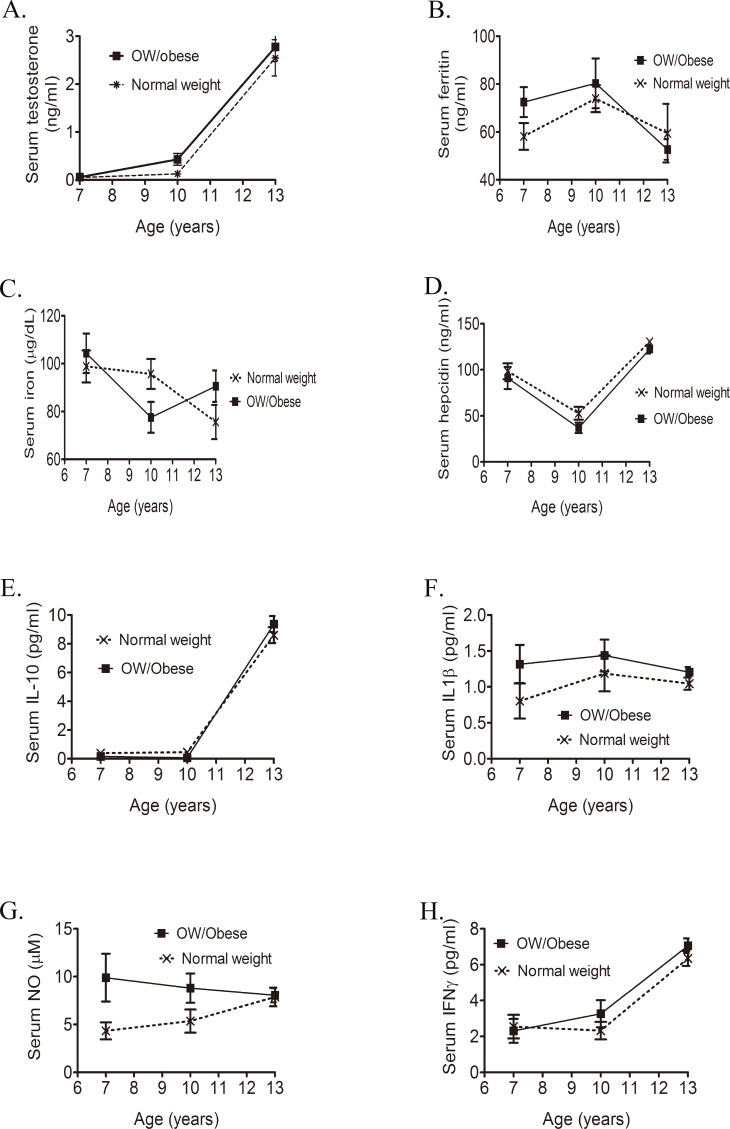
Distributions of serum testosterone (A), ferritin (B), iron (C) hepcidin (D), interleukin (IL)-10 (E), IL-1β (F), nitric oxide (NO) (G), and interferon (IFN)-γ (H) stratified by age and the body-mass index (BMI) (n = 137).